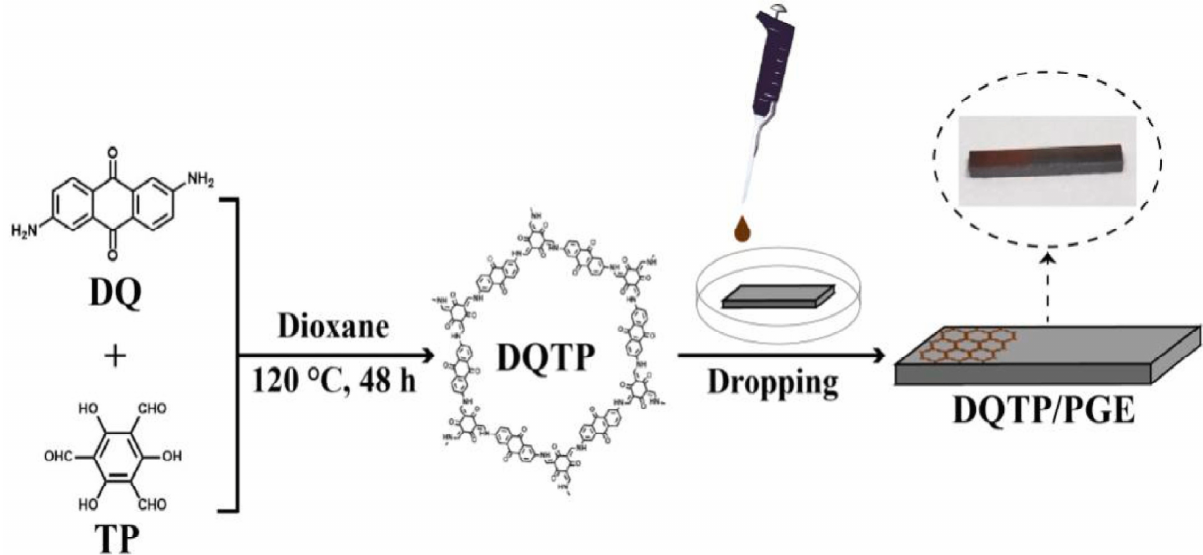
Figure 12. Graphical illustration for a 3D-printed electrochemical electrode clamp based DQTP/PGE for the simultaneous determination of bisphenol A and bisphenol S [54].